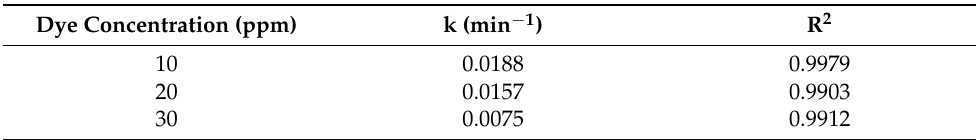
Figure 8. Kinetic study of RR 198 decolorization with different dye concentrations (catalyst dosage 0.10 g/L and pH 5, as well as C 0 and C, are the initial and final concentrations). Table 1. Reaction rate constants and correlation